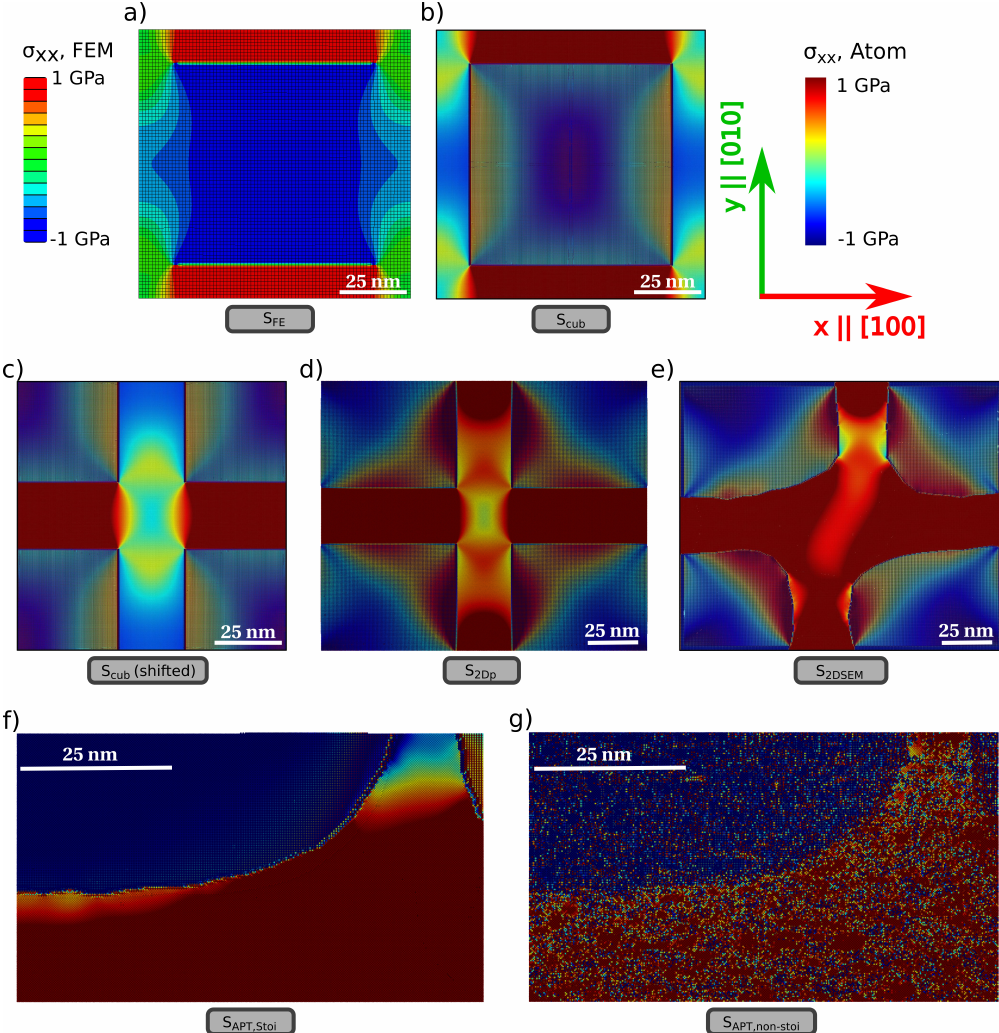
Figure 3. Internal stress distribution in the different samples used in the current work: ( a ) FEM sample S FE ; ( b ) Atomistic sample S cub ; ( c ) To help facilitate comparison with other atomistic samples, sample S cub is shifted periodically so that the channels are now in the center of the picture; ( d ) Atomistic sample S 2 Dp ; ( e ) Atomistic sample S 2 DSEM obtained by digitizing SEM micrograph; ( f ) APT-informed atomistic sample S APT , stoi with stoichiometric chemical composition; ( g ) APT-informed atomistic sample S APT , non − stoi with non-stoichiometric chemical composition. All samples are oriented such that x (cid:107) [ 100 ] and y (cid:107) [ 010 ] . All atomistic samples share the same color